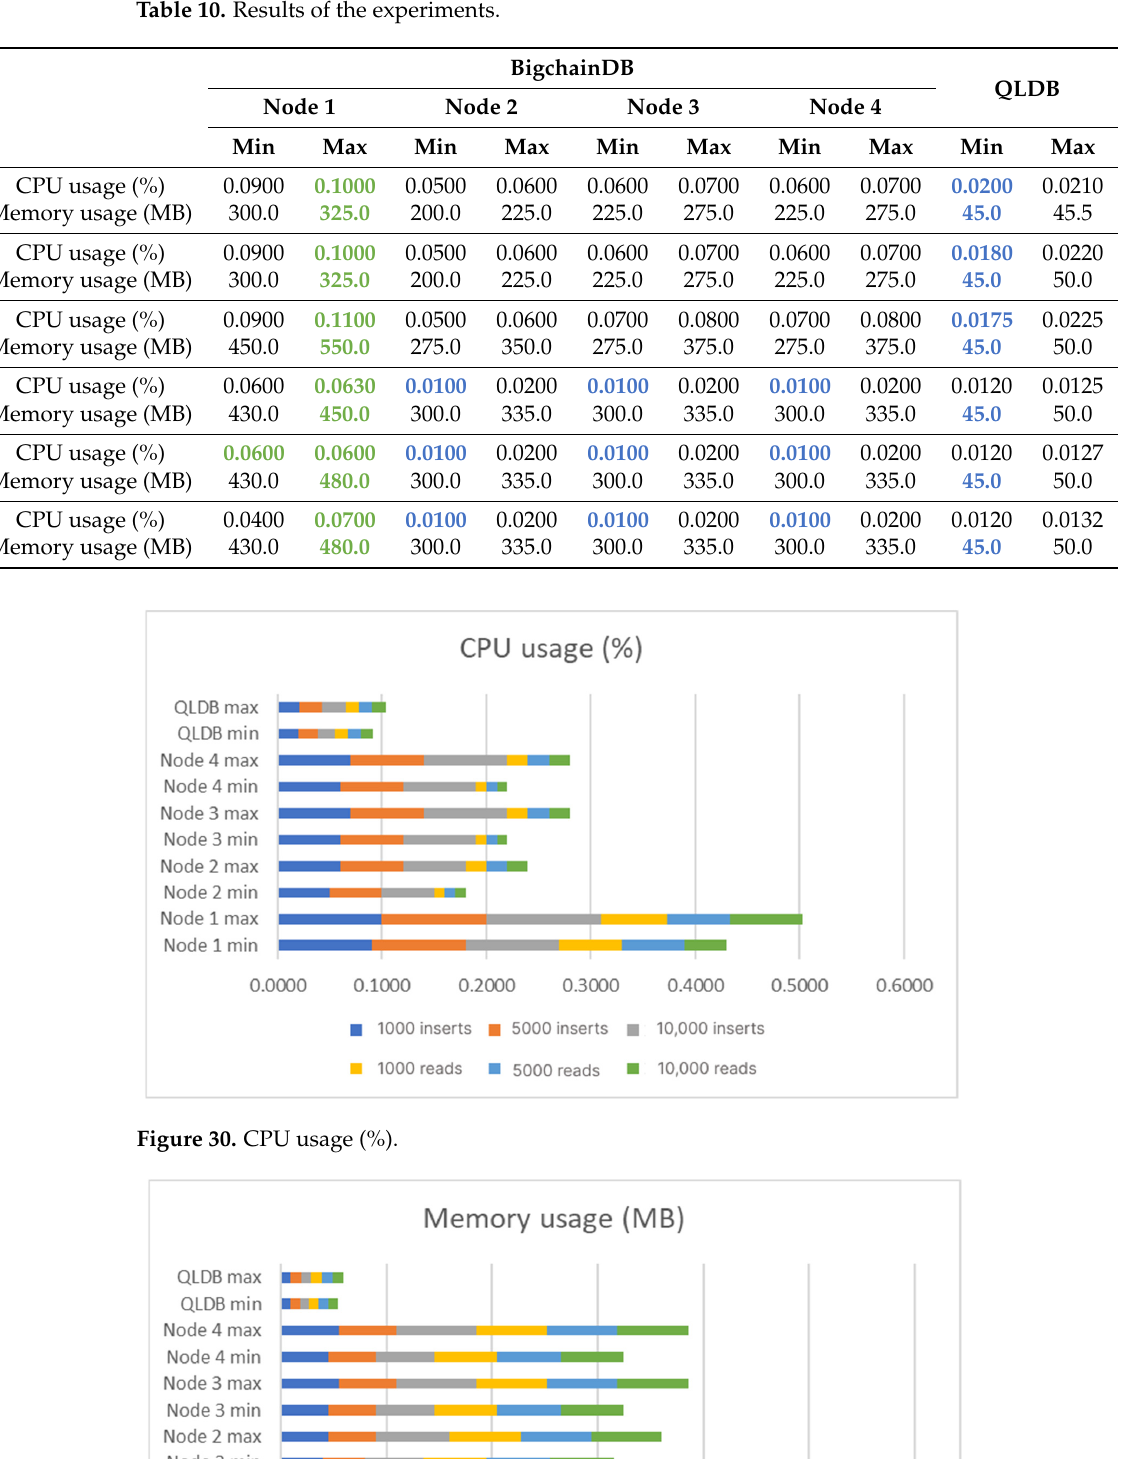
Table 10. Results of the experiments.